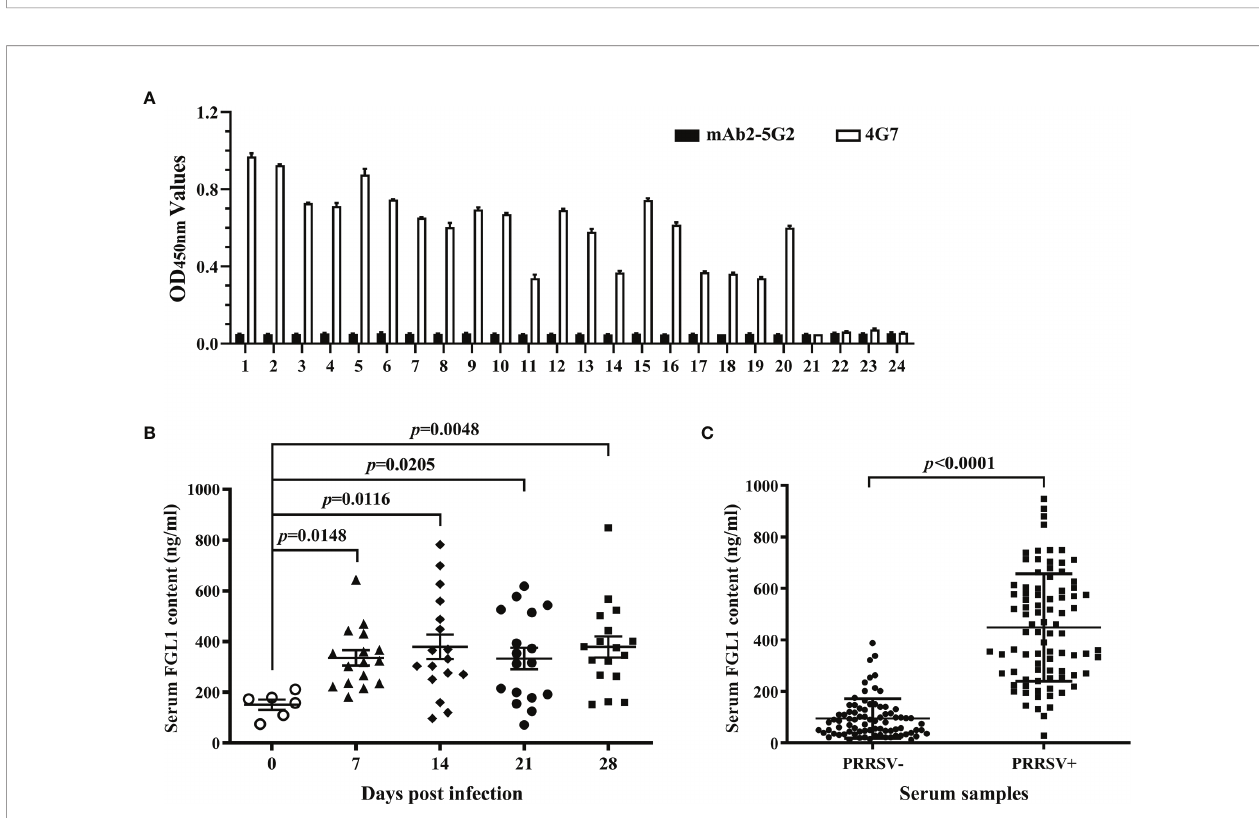
FIGURE 6 | Applicability of the developed DAS-ELISA. (A) Twenty PRRSV-positive pig sera and four PRRSV-negative pig sera were detected with the developed DAS-ELISA. mAb2-5G2 was used as a control capture antibody. (B) Series serum samples of SPF pig infected with PRRSV JAX1 strain were analyzed with the developed DAS-ELISA. (C) Clinically PRRSV-negative and -positive pig serum samples were analyzed with the developed